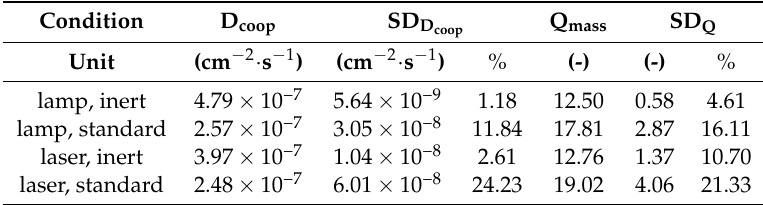
Table 1. Hydrogel characteristics cooperative diffusion coefficient D coop and degree of swelling Q mass at different polymerisation conditions (standard or inert, lamp or